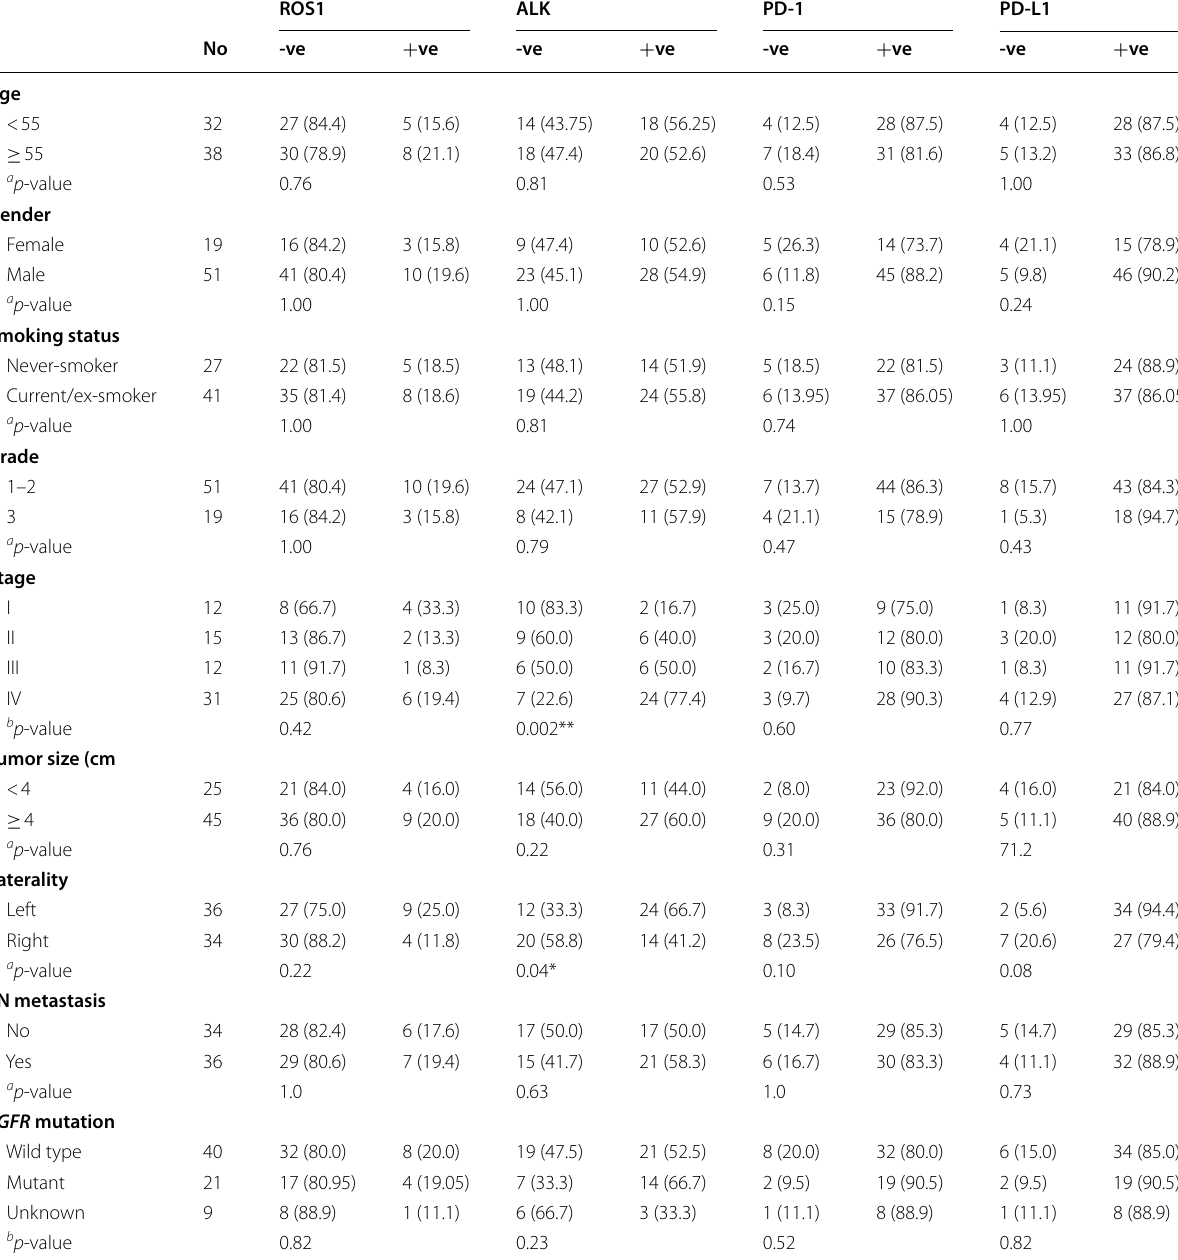
Table 2 Clinicopathological characteristics in association with ROS1, ALK, PD‑1, and PD‑L1 proteins